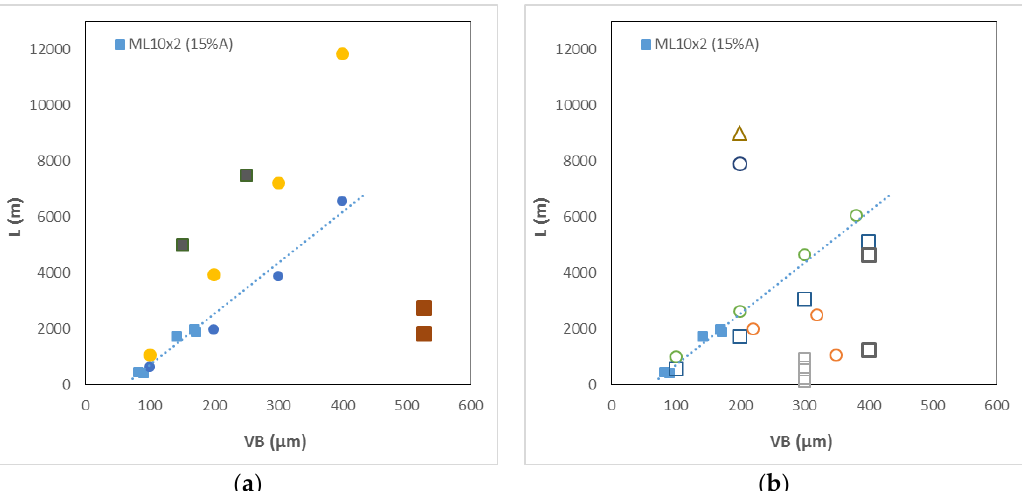
Figure 7. Tool machining length given as a function of flank wear of diamond tools (squares for CVD coated inserts, circles for PCD inserts and triangle for brazed thick CVD; filled symbols—workpiece material contains Al 2 O 3 ; open symbols—reinforcing particles are SiC; dotted line corresponds to an extrapolation of ML10x2 results (filled blue squares). ( a ) —CVD/15% Al 2 O 3 , present work; —